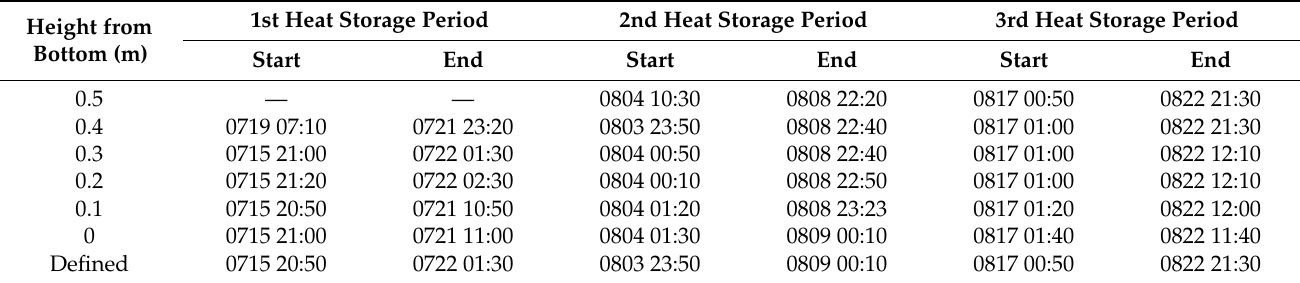
Table 2. Start and end day and time for each heat storage period defined by slopes of change point analysis. Height from Bottom